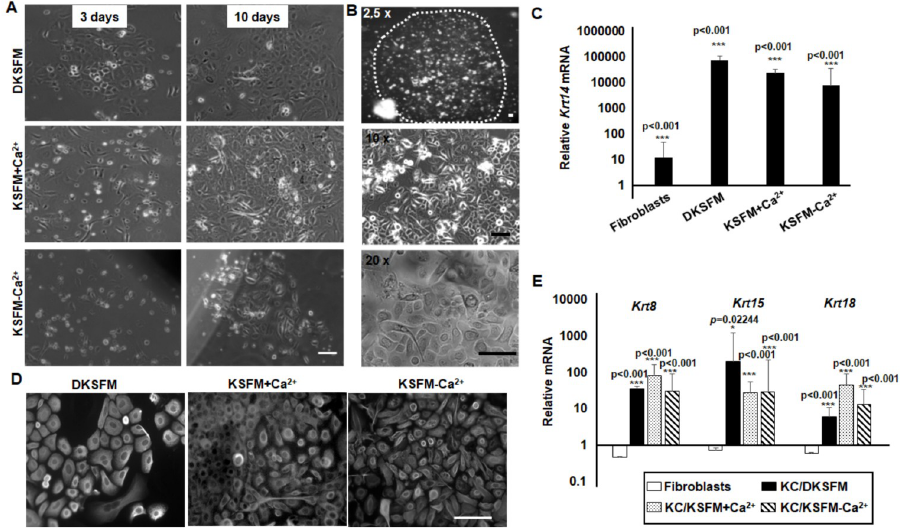
Fig 1. Mouse keratinocyte culture in different conditions. Bright-field microscopic images of (A) cells grown for 3 or 10 days in different media, and (B) colonies formed when cells were grown in KSFM-Ca 2+ medium for an extended period of time. The relative expression of (C) the basal keratinocyte gene Krt14 and (E) epithelial marker genes, i.e. Krt8 , Krt15 and Krt18 , in cultured keratinocytes and fibroblasts compared to those in mESCs. (D) Cells were subjected to immunofluorescence staining with anti-KRT14; photographs were taken under fluorescent microscope. Results represent data of at least three duplicate experiments +/-SD. The scale bars in microscope image correspond to 100 μ m.